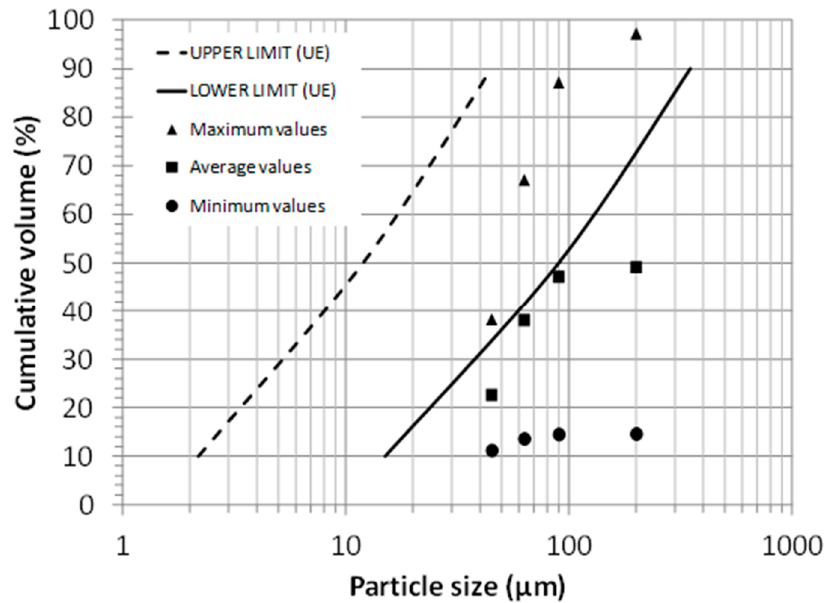
Figure 3. Maximum, average and minimum values of the Carboneras coal fly ash and the upper and lower ranges of the particle size distribution of 23 European coal fly ashes [58].